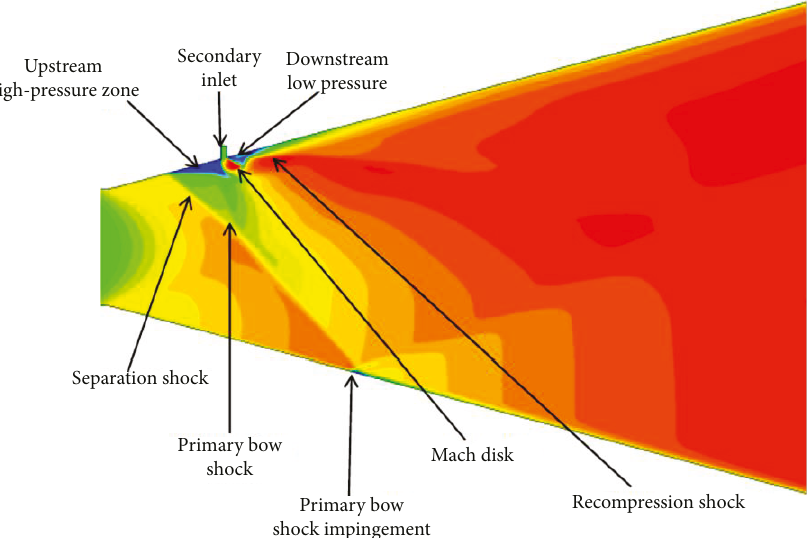
Figure 11: SITVC nozzle fl ow fi eld structure (Mach number contour).